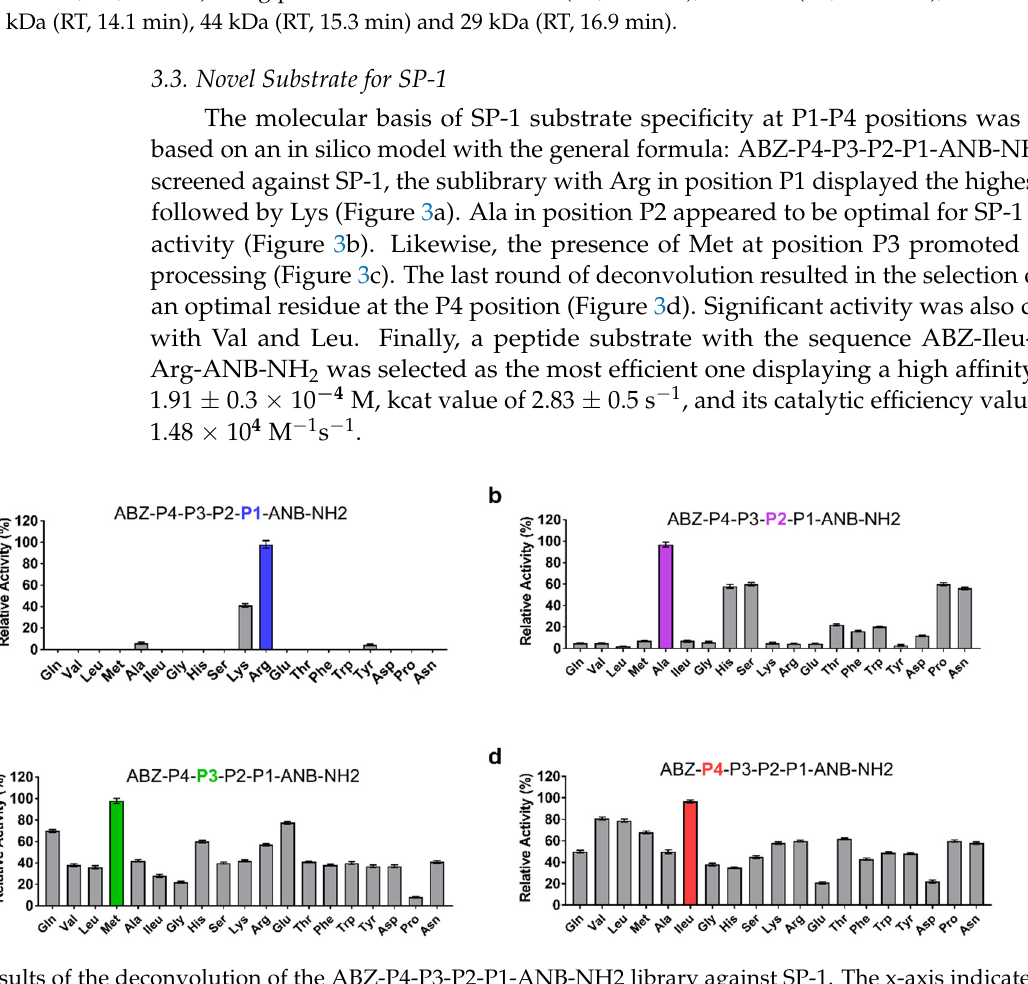
Figure 3. Results of the deconvolution of the ABZ-P4-P3-P2-P1-ANB-NH2 library against SP-1. The x-axis indicates the amino acid fixed at each P position. P1, P2, P3, and P4 correspond to the mixture of 19 amino acid residues. ( a ) P1 position was fixed with the most active residue ( b ) P2, ( c ) P3 and ( d ) P4 profiling were performed in a similar manner. All measurements were performed in triplicate, and the y-axis indicates the activity (mean ± SEM) relative to the mean value of the highest signal detected for each P position.